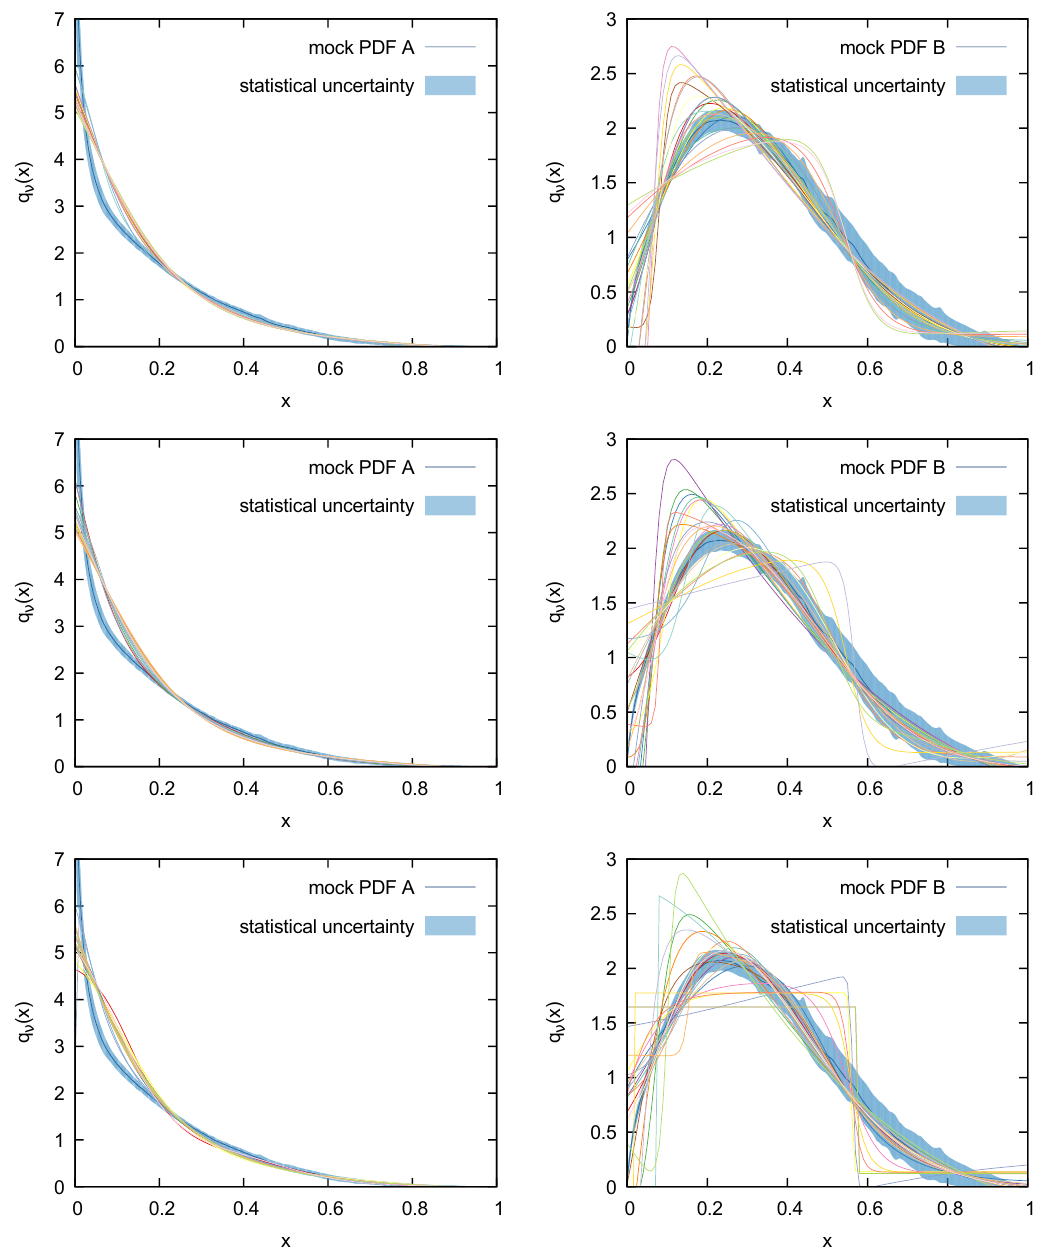
Figure 8 . The genetically trained neural nets. The blue band is the original data. The curves are the responses for the (cid:12)nal population of genetically trained neural networks. The left column is with NNPDF data. The right column is with modi(cid:12)ed data. The (cid:12)rst row has a network geometry of 1-3-1. The second row has a geometry of 1-4-1. The third row has a geometry of 1-2-2-1.